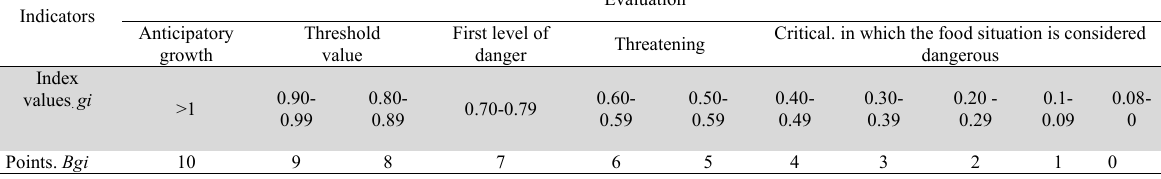
Points evaluation indicators of the region's strategic potential in the field of food